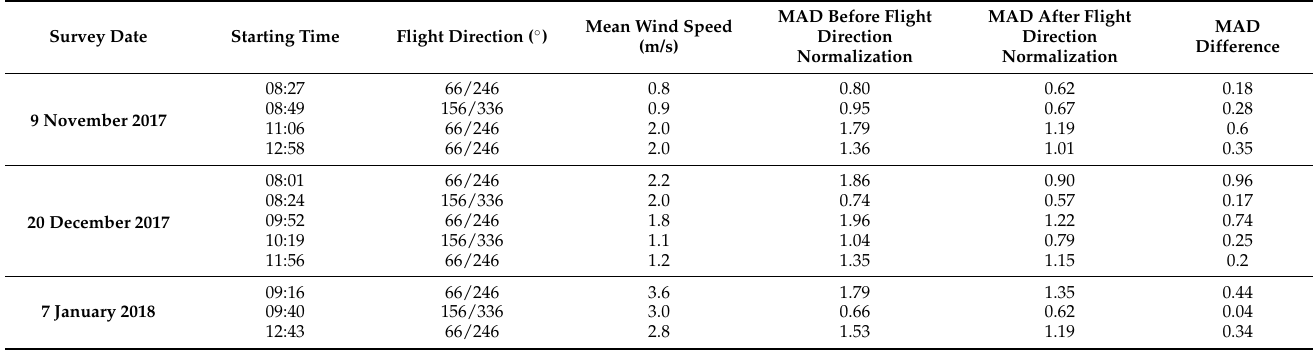
Table 2. Mean absolute difference (MAD) between inbound and outbound orthophotos before and after flight direction normalization and associated starting times, flight directions and mean wind speeds of all 12 UAV